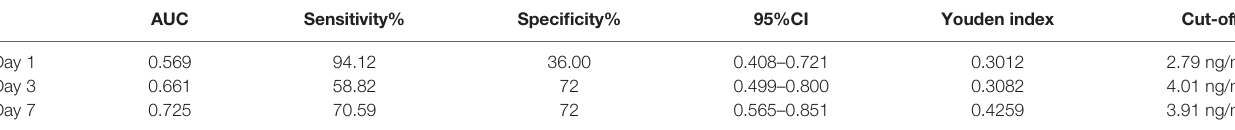
TABLE 4 | ROC curve analysis of dynamic monitoring GDF15 in sepsis and septic shock. AUC Sensitivity% Speci fi city% 95%CI Youden index